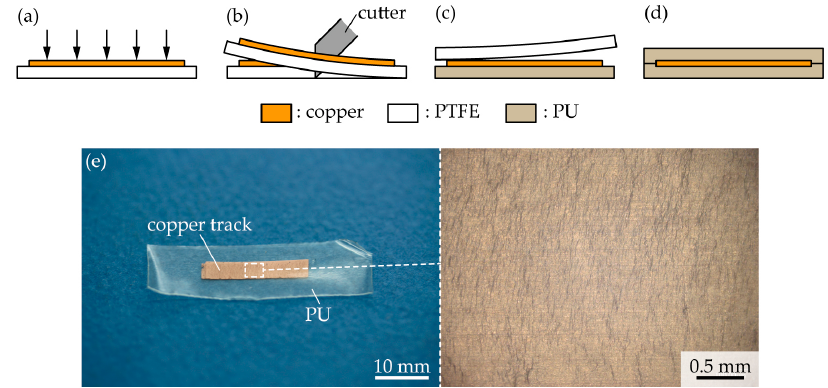
Figure 2. Fabrication of a straight ‐ shaped copper track embedded in PU. ( a ) Thermal deposition of a copper layer on a polytetrafluoroethylene (PTFE) sheet; ( b ) Cutting of the PTFE sheet; ( c ) Transfer of the copper track onto a polyurethane (PU) tape; ( d ) Lamination of another PU tape; and, ( e ) Optical images of the fabricated copper track in PU.